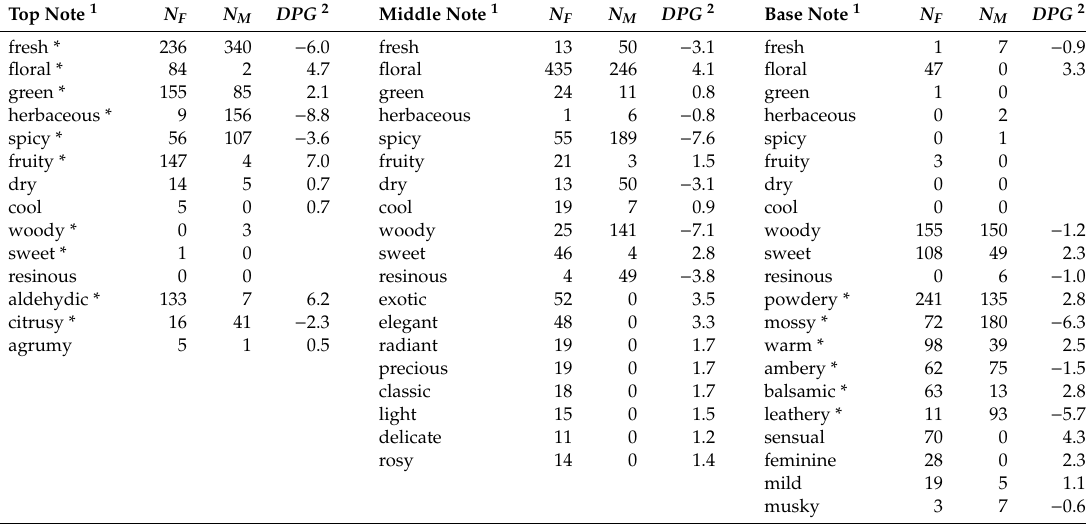
Table 3. List of odor character descriptors used by H&R [3] to describe the olfactory notes of 820 perfumes (453 women’s and 367 men’s). The table indicates the number of feminine ( N F ) and masculine ( N M ) fragrances in the H&R guide labeled with a given term to describe either the top, middle, or base